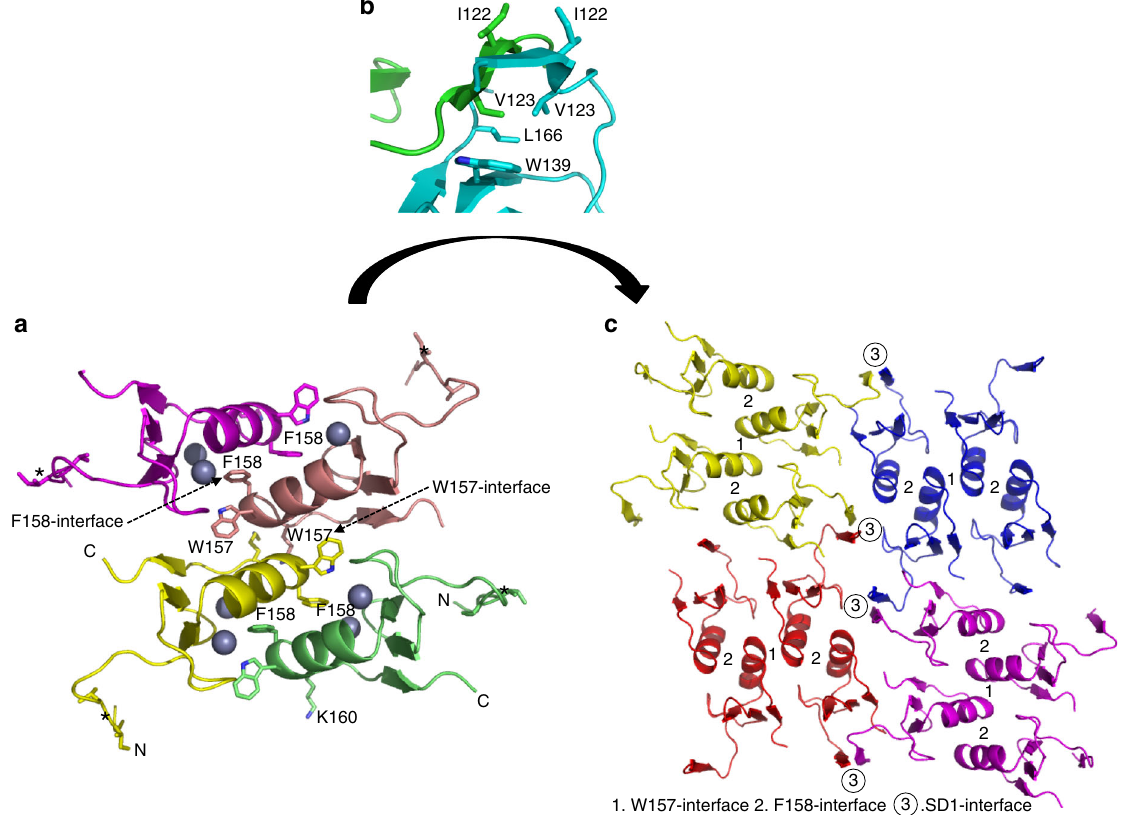
Fig. 3 Crystal packing reveals an oligomerization network by PML B1-box. a A possible B1 tetramer. B1 monomers are colored in magenta, brown, yellow, and green, respectively. The W157- and F158-interfaces are arrowed. The SD1-interface is highlighted with “ * ” . Residues I122, V123, W157, F158, and K160 are shown in stick representation. b Enlarged view of SD1 – SD1 dimer. The residues that facilitate the formation of this dimerization are shown in stick representation. c B1-box polymers (N-mer). The W157/F158-tetramers are colored in yellow, blue, purple, and red, respectively. B1 networking is mediated by W157-, F158-, and SD1